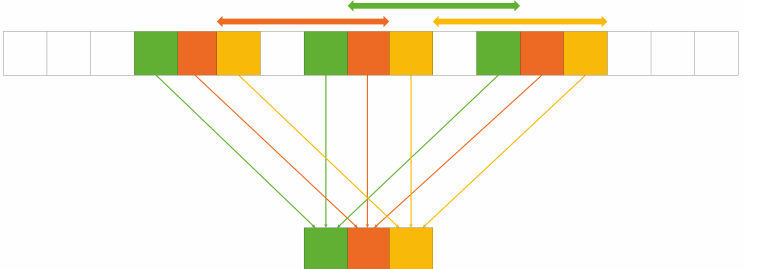
Figure 5. Concept of spectral feature extraction using 1D-Atrous Convolution: Example has 3 kernel size and 3 rate size.